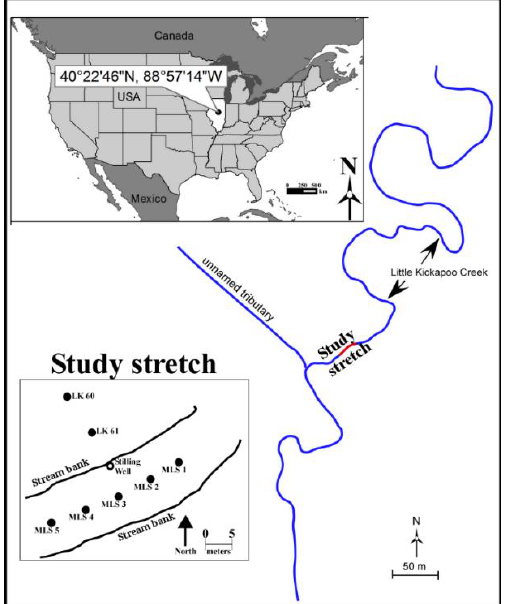
Figure 1. Location of the stretch of Little Kickapoo Creek (LKC) (40 °22′46″ N, 88°57′14″ W) with a detailed presentation of the array of multi-level samples (MLS) within the study stretch.